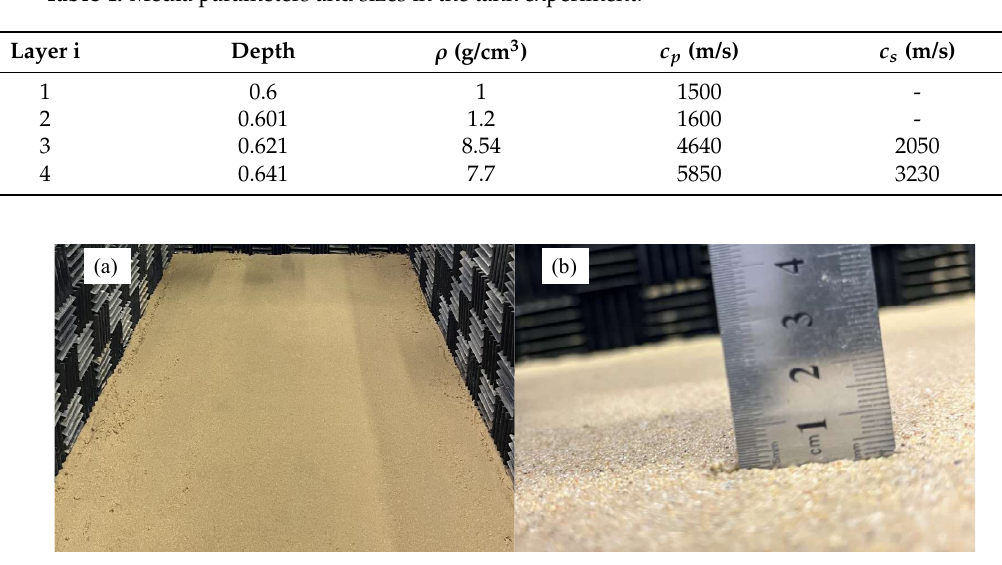
Table 4. Media parameters and sizes in the tank experiment.